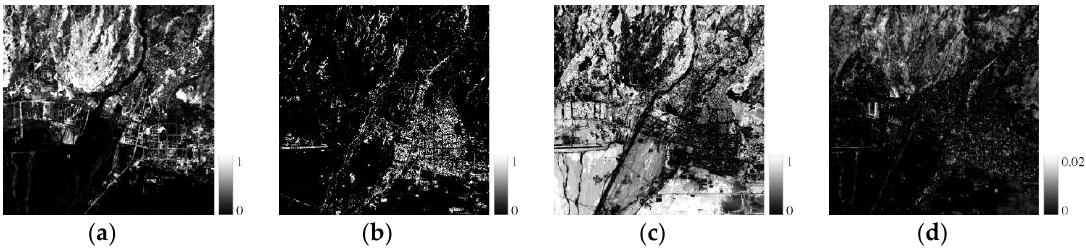
Figure 10. Fraction and error (study area 2). ( a ) Vegetation, ( b ) Impervious surface, ( c ) Bare soil, ( d ) RMSE.